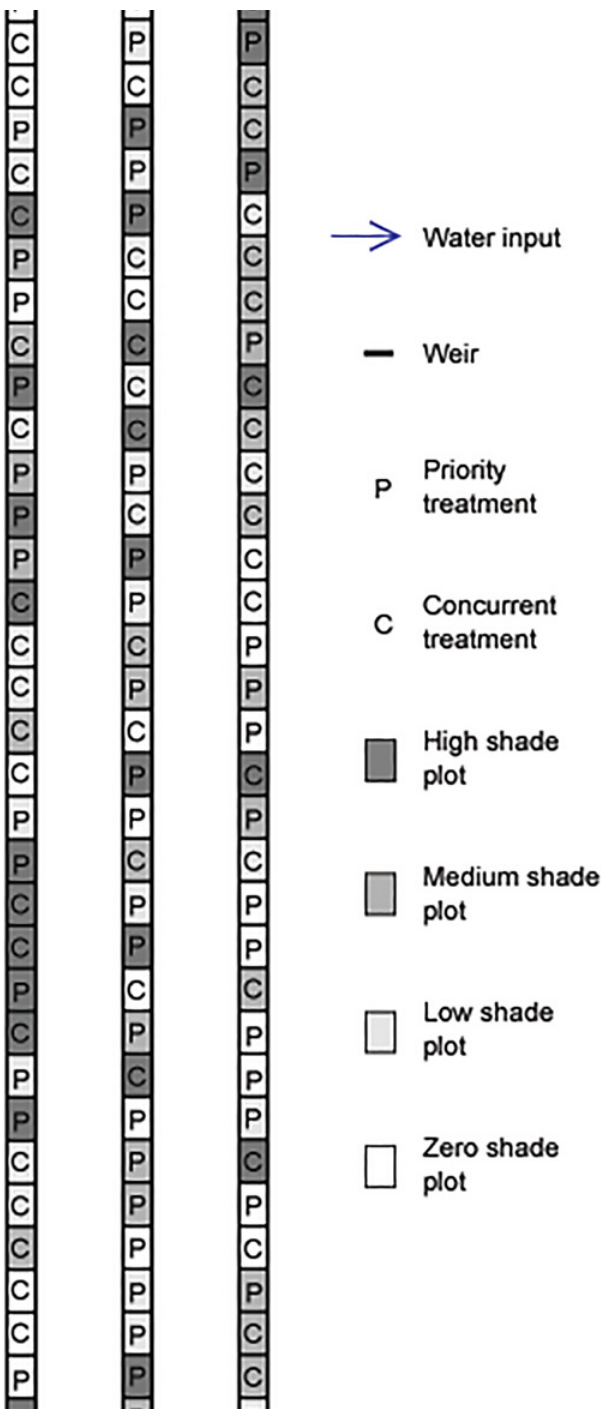
Fig 1. Diagram of experimental layout in artificial channels. Water flowed through the entire channel system with inputs at the upstream end of each of the three channels.